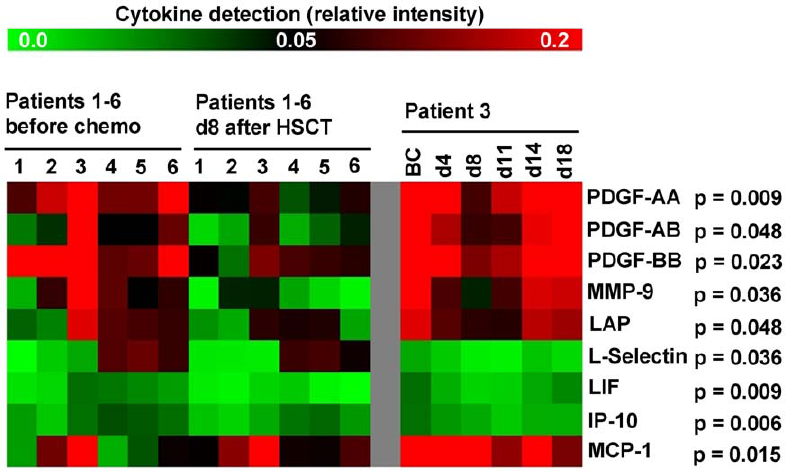
Figure 5. Chemokine profiling in the course of HSCT. 174 human serum proteins were analyzed in serum samples of six patients ( # 1–6) obtained before chemotherapy (BC) or at day 8 after HSCT. Detection of platelet-derived growth factor (PDGF)-AA, -AB, -BB, matrix metallopeptidase - 9 (MMP-9), leukocyte alkaline phosphatase (LAP), L-Selectin, leukemia inhibitory factor (LIF) and chemokine [C-X-C motif] ligand 10 (IP-10) was higher before chemotherapy, whereas only chemokine [C-C motif] ligand 2 (MCP-1) significantly increased after chemotherapy. Additional comparison of chemokine profiles in serum samples at further time points (BC and from d4, d8, d11, d14 and d18 after HSCT) revealed that these changes in growth- factor concentration are transient during aplasia and normalize after hematopoietic recovery.